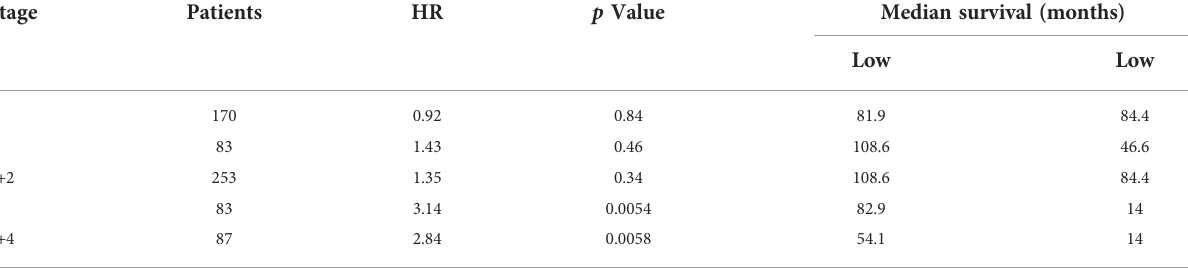
TABLE 2 Correlation between the CLGN mRNA expression and patient OS at different pathological stages. Stage Patients HR p Value Median survival